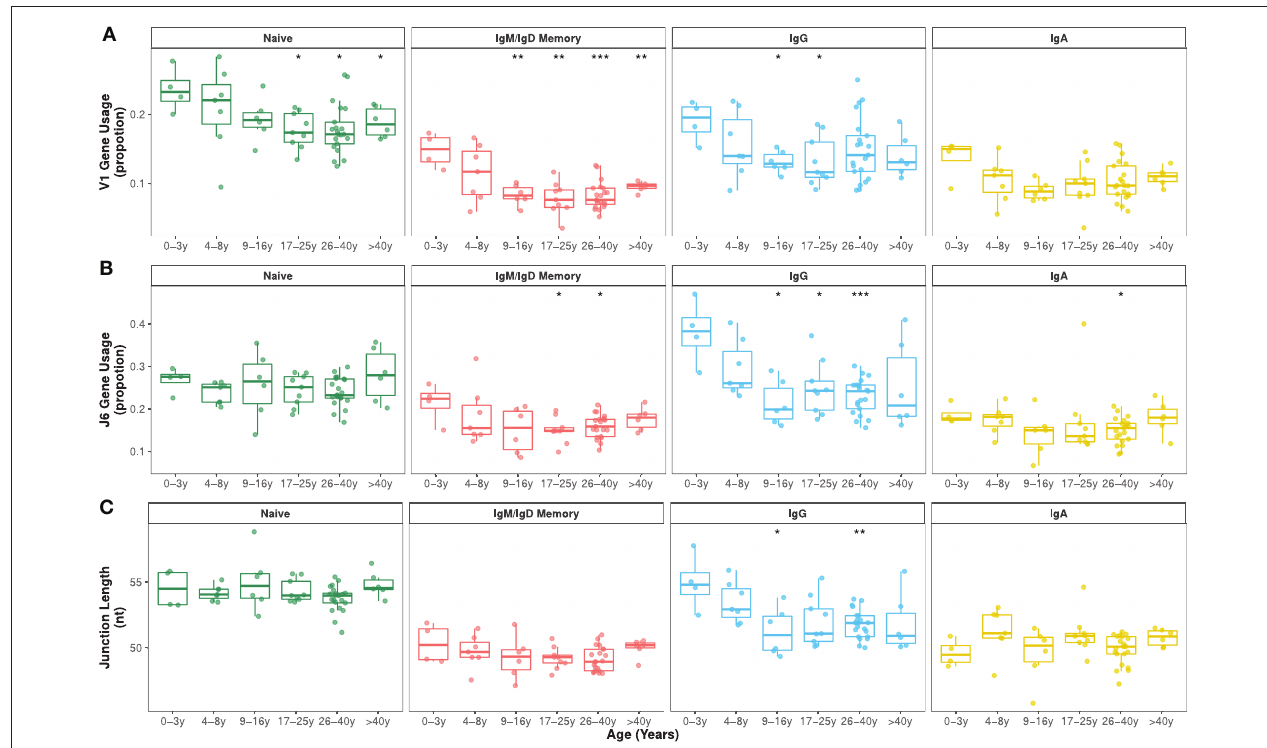
FIGURE 1 | V family and J gene usage changes in early childhood. (A) V1 family usage was significantly reduced in older compared with younger individuals in all IgH repertoires. (B) J6 gene usage significantly decreased during the first 10 years of life mostly in IgG subsets. (C) Mean junction length significantly decreased in the first 10 years of life exclusively in IgG subsets. Comparison of each age group to the 0–3y group was performed using the Wilcoxon test. * p < 0.05, ** p < 0.01, *** p <